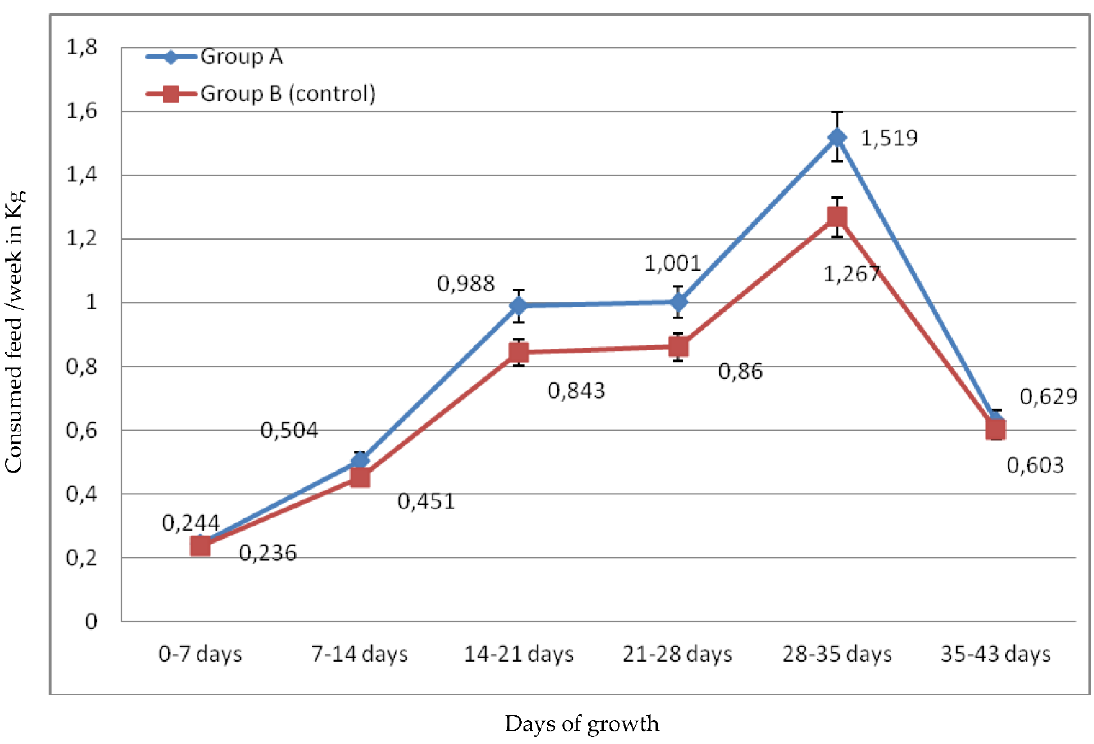
Figure 1. Broiler average weight after 43 days of growth. Broilers of group A, fed with ration supplemented with pulp and seeds of pomegranate and avocado by-products, and broilers of group B (control group), fed with basal ration.